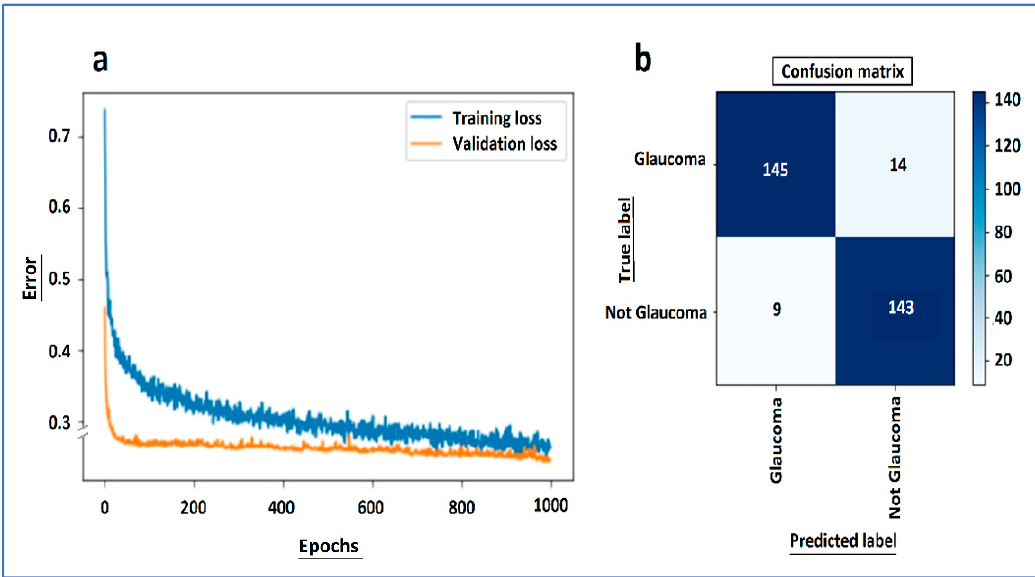
Figure A1. From the normal vs. glaucoma neural network: ( a ) learning curve of the training and validation loss and ( b ) confusion matrix of the test dataset.